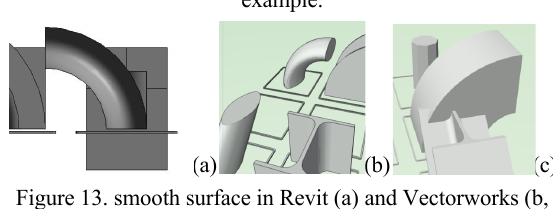
Figure 12. IFC geometries visualised in ArchiCAD, as an example.